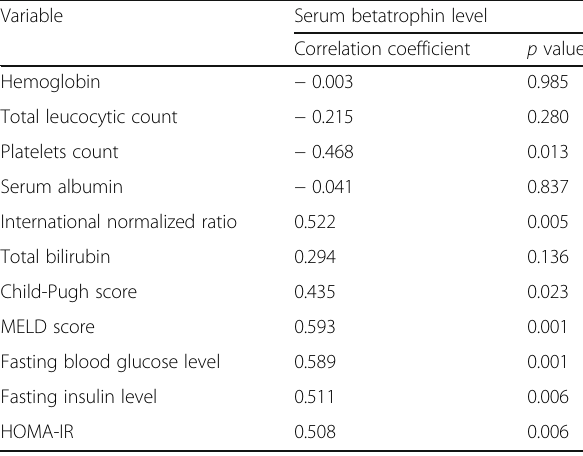
Table 3 Correlations between serum betatrophin level and other variables in the cirrhosis